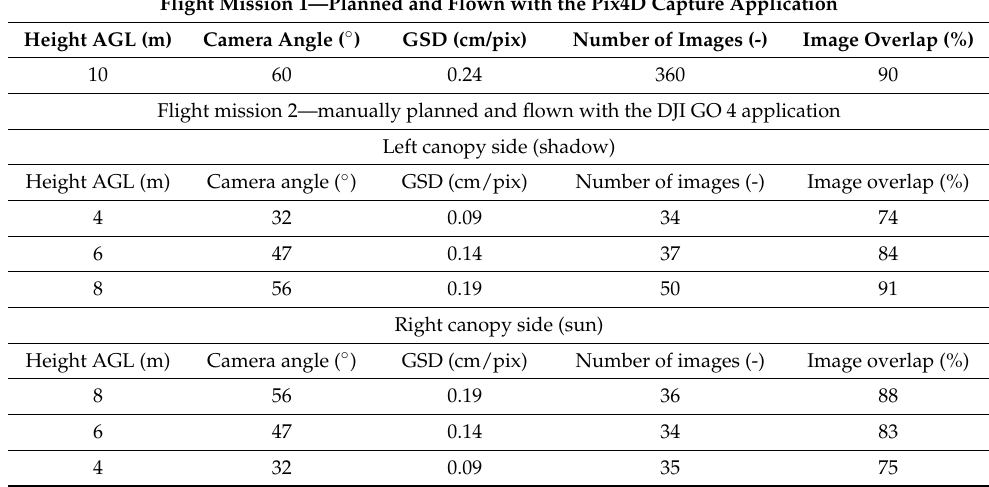
Table 1. Summary of flight parameters for the flight